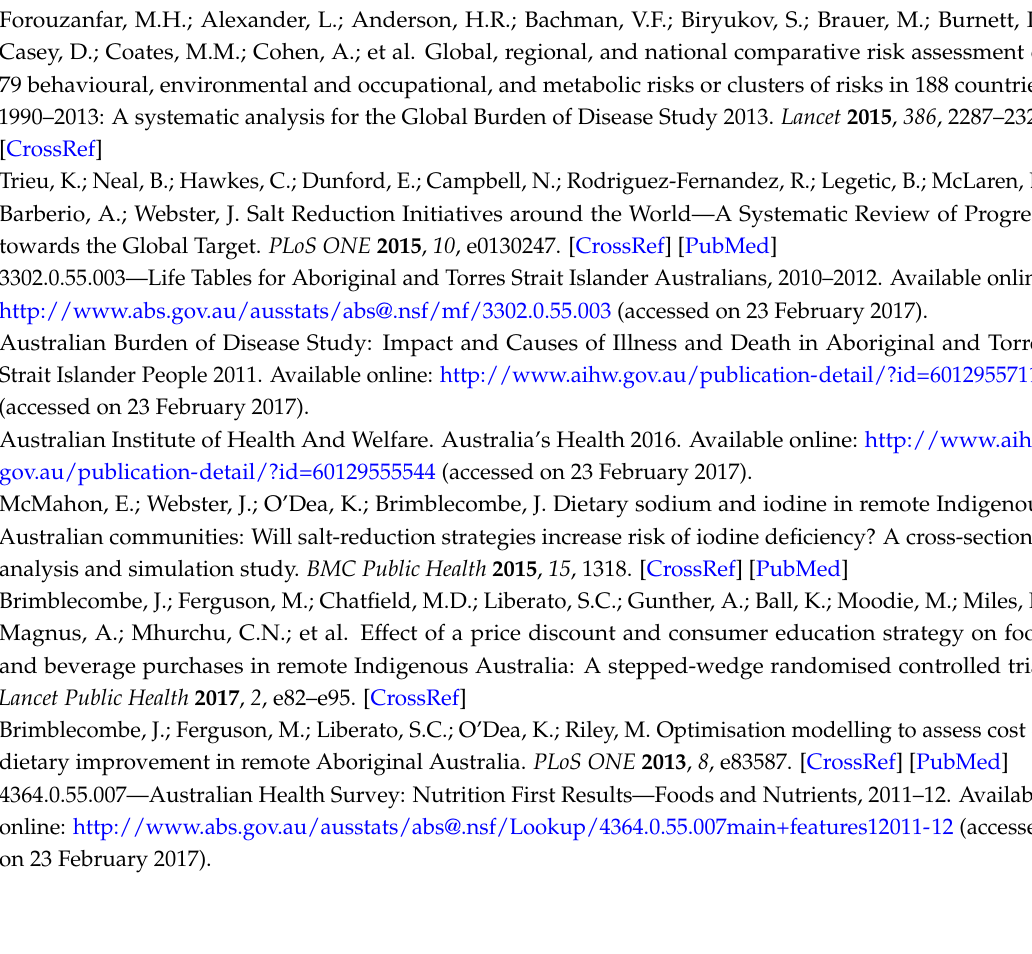
Table S1: Outcomes for each of the study periods, Table S2.1: Description of